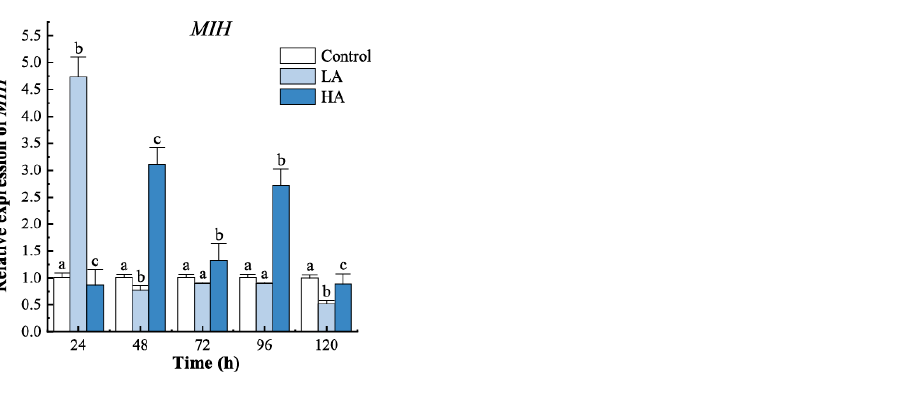
Figure 4. Expression patterns of Halloween family genes in juvenile crabs exposed to ammonia ni- trogen stress. ( a ) Spo , ( b ) Dib , and ( c ) Sad . At the same time, the letters indicate significant differences between experimental groups ( p < 0.05).